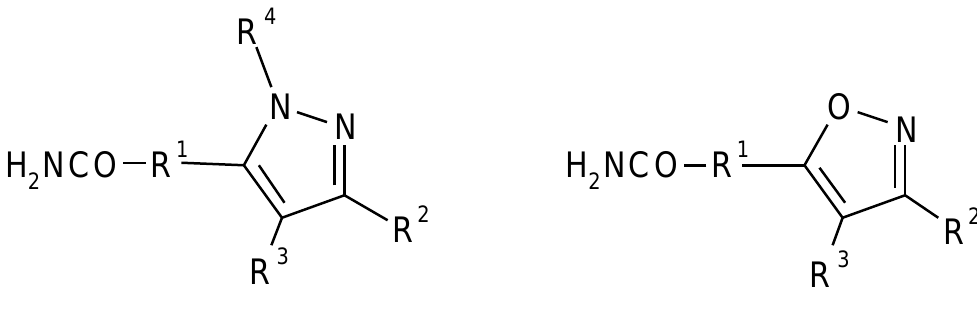
Figure 1. Pursued substitution pattern on the pyrazole and isoxazole scaffolds.